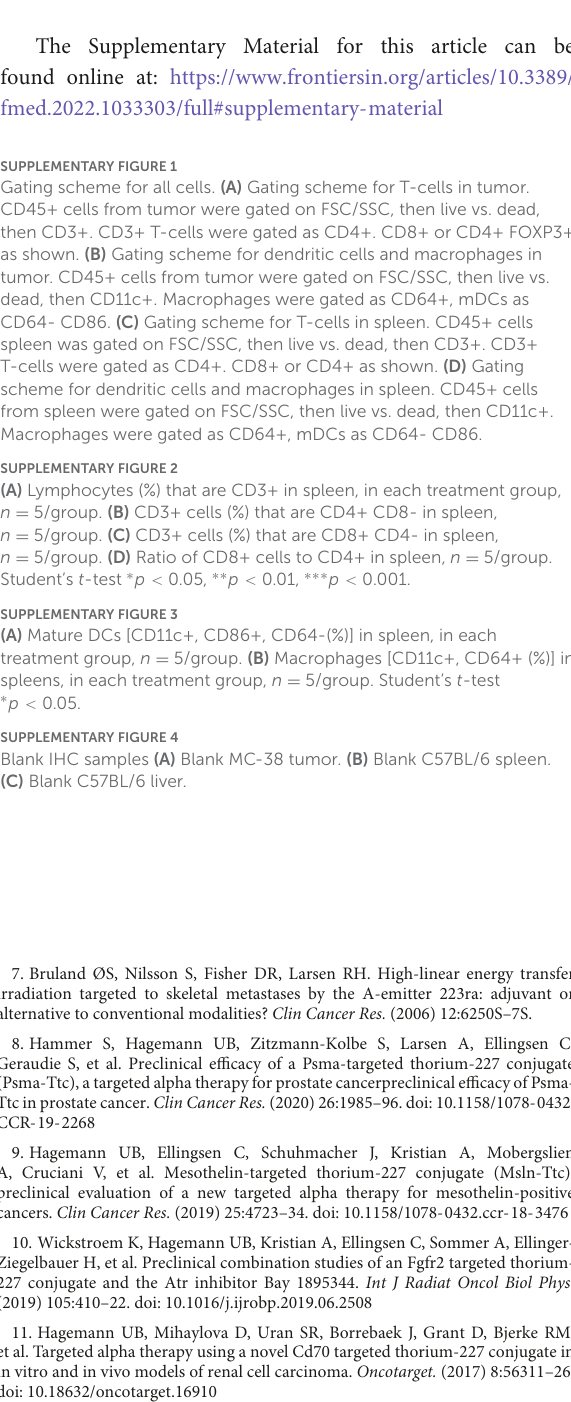
T-cells were gated as CD4+. CD8+ or CD4+ as shown. (D) Gating scheme for dendritic cells and macrophages in spleen. CD45+